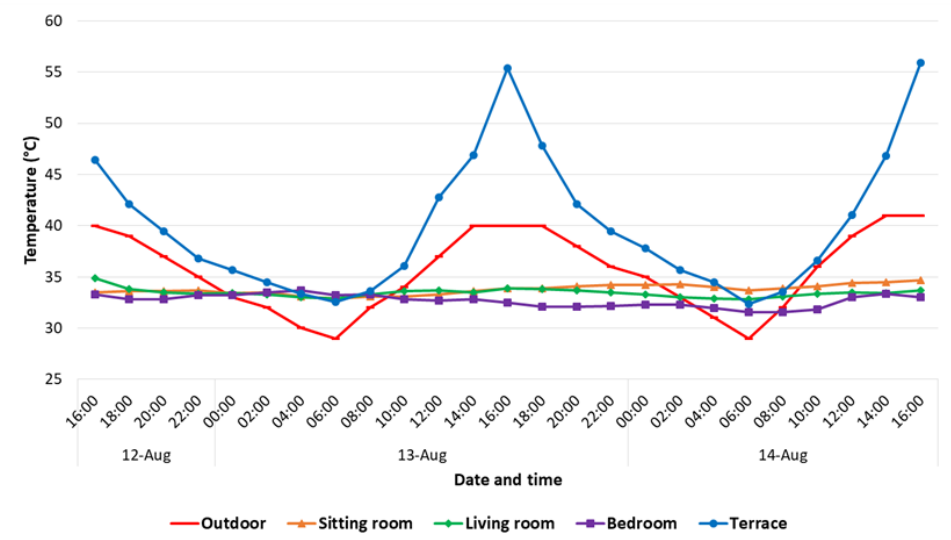
Figure 12. Variation in the average radiant temperature.